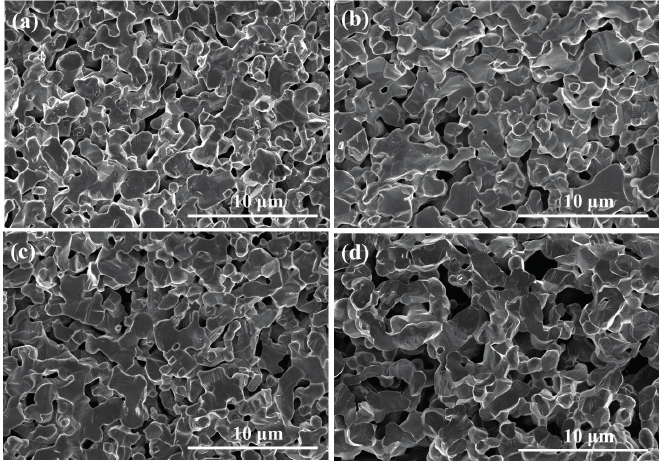
Figure 6. SEM micrographs of thick LSM95 layers, ( a ) 15 wt % carbon; ( b ) 30 wt % carbon;